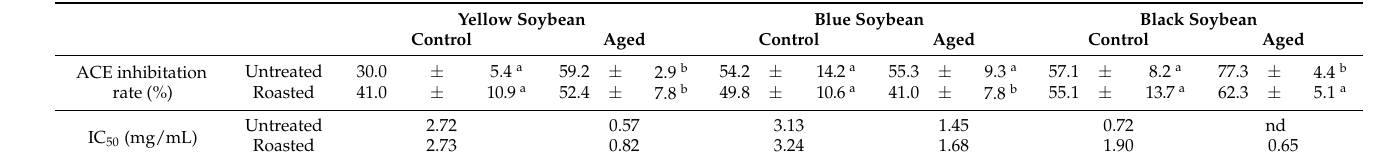
Table 5. ACE inhibitory activity of soybeans affected by storage and roasting.